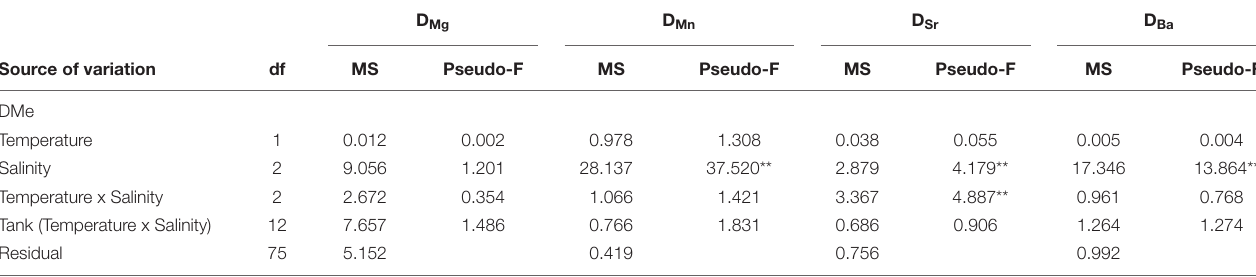
TABLE 5 | Results of the permutational analysis of variance (PERMANOVA) investigating the effects of salinity and temperature on the partition coefficients of magnesium (D Mg ), manganese (D Mn ), strontium (D Sr ) and barium (D Ba